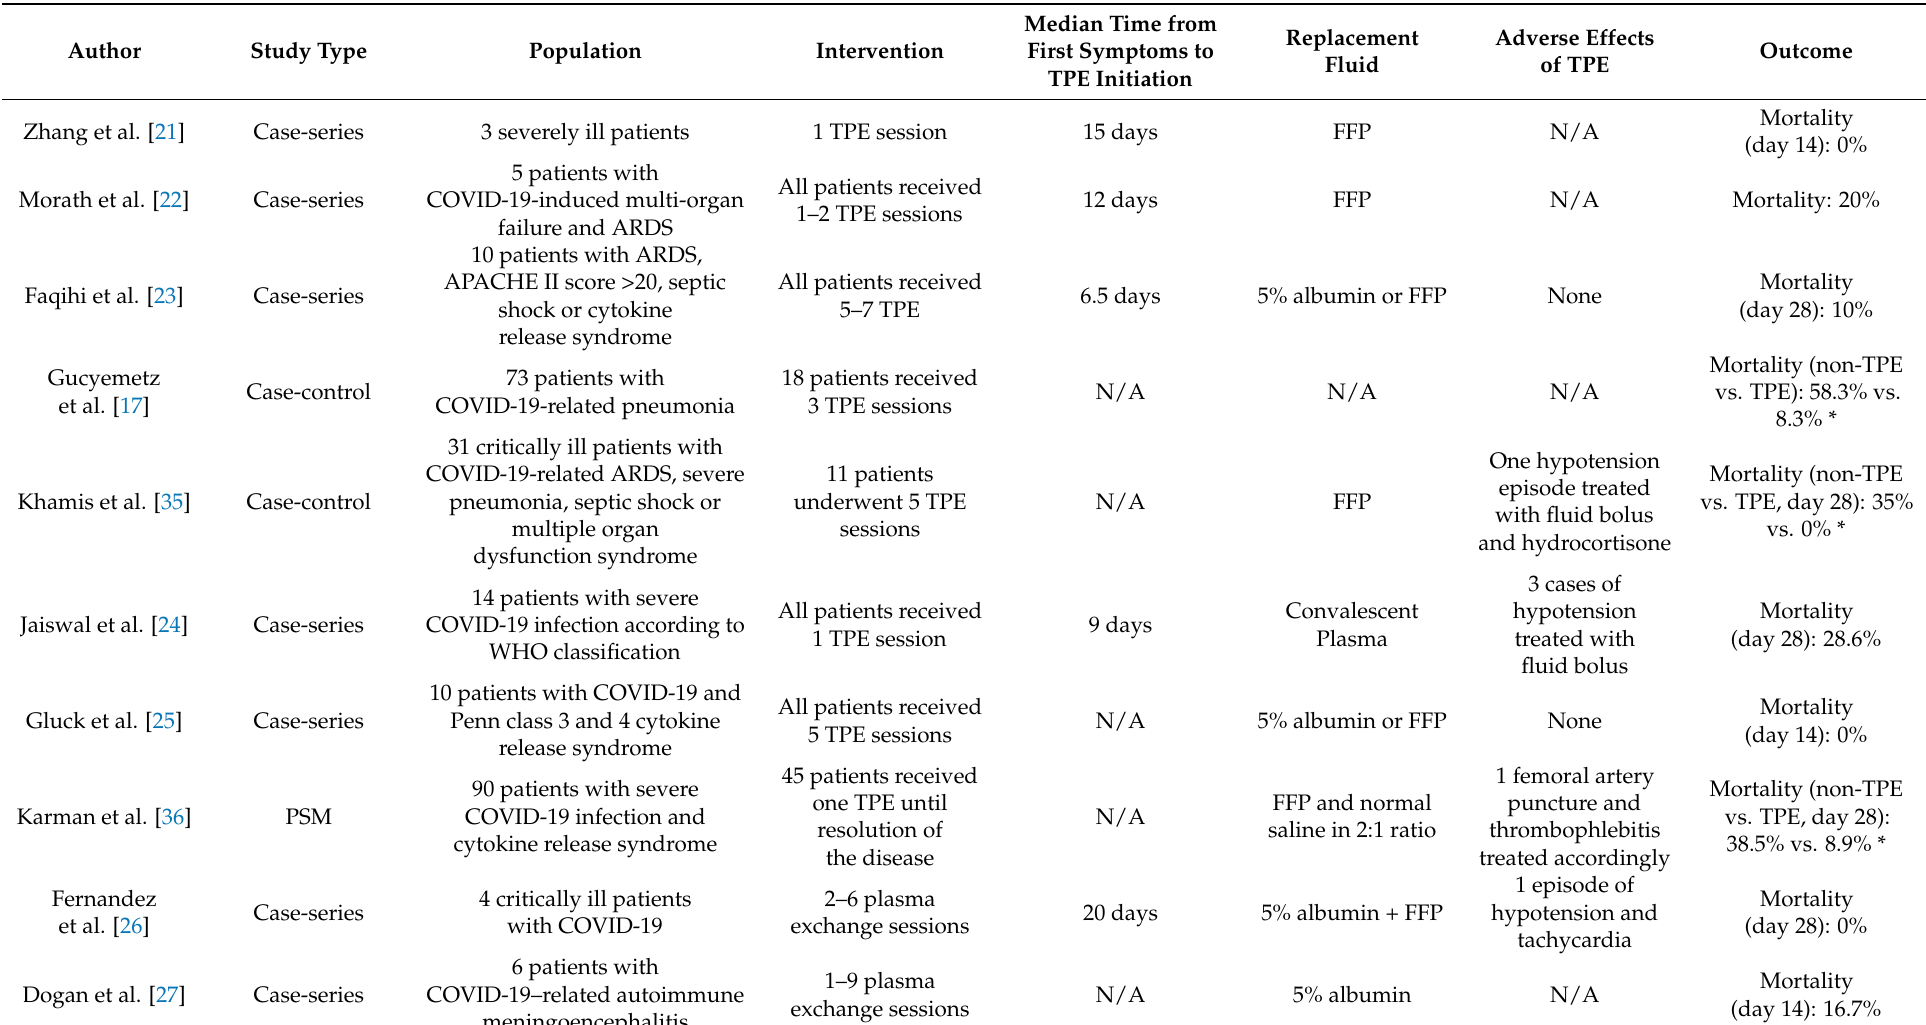
Table 2. Summary of the included